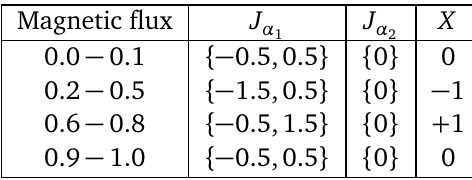
Table 1: Spin quantum number configurations with the flux for N = 2 and M = spin with M 1 2